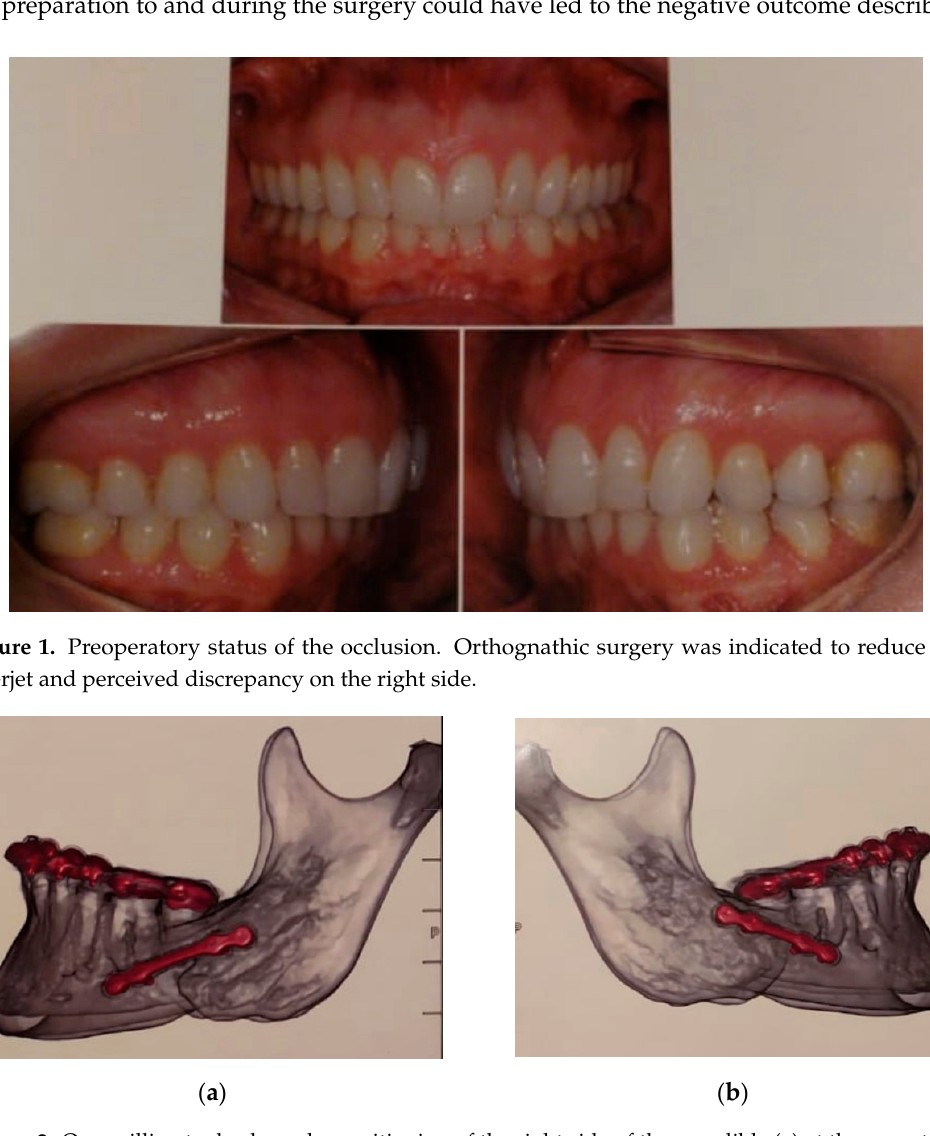
Figure 2. One-millimeter backward repositioning of the right side of the mandible ( a ) at the same time that the left side was advanced 1.5 mm ( b ).